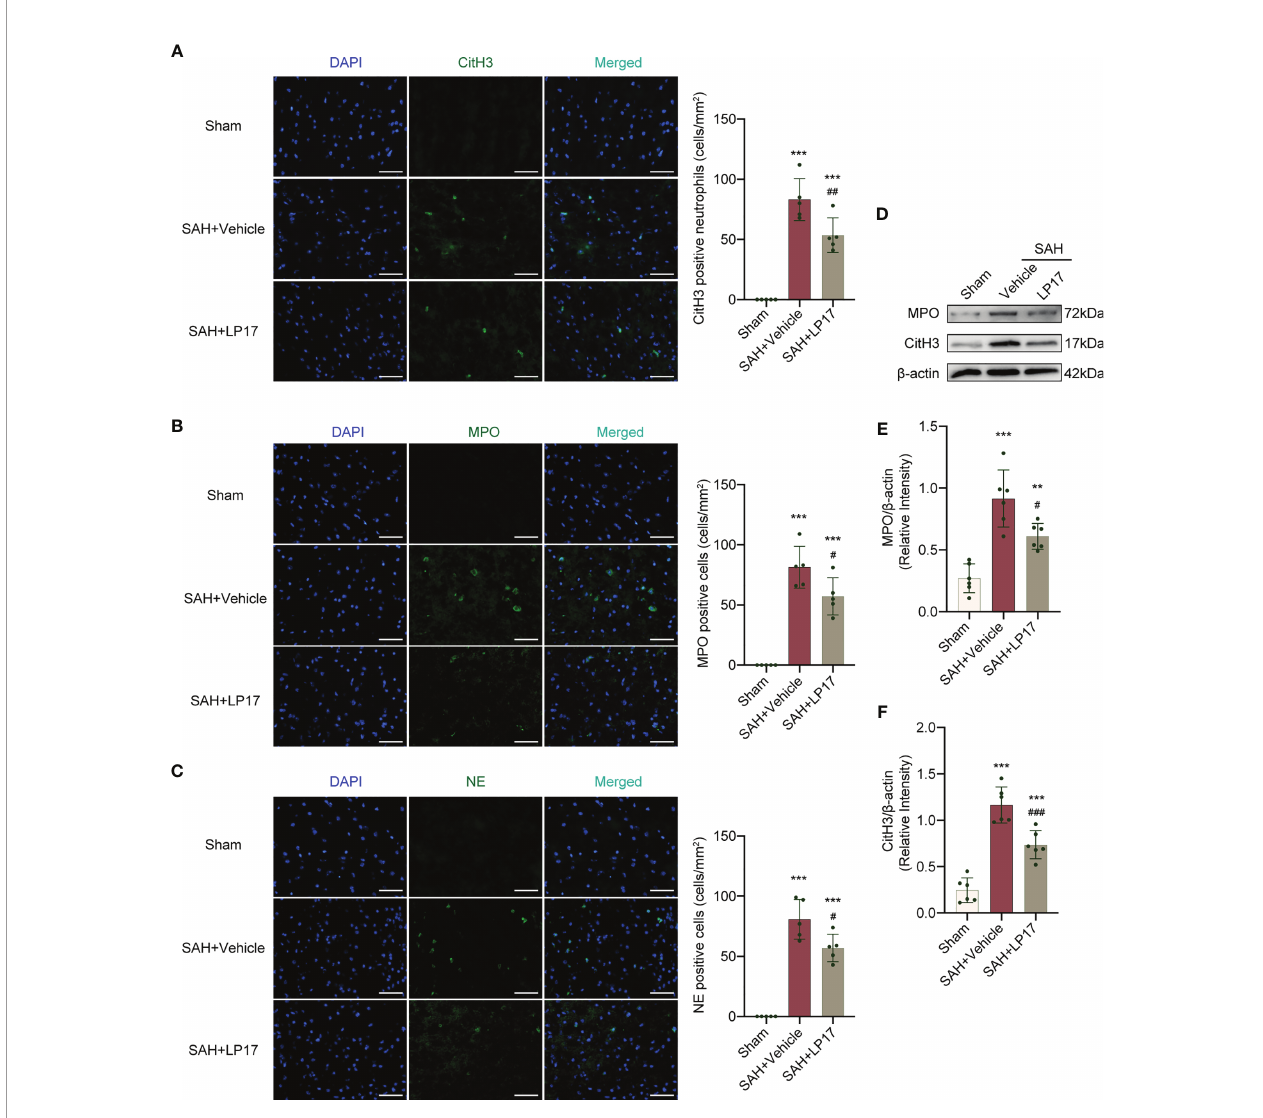
FIGURE 5 | LP17 treatment inhibited the formation of NETs. (A) Representative photograph and quantitative analysis showed the CitH3 positive cell (green) in different groups. n = 5/group. (B) Representative photograph and quantitative analysis showed the MPO positive cell (green) in different groups. n = 5/group. (C) Representative photograph and quantitative analysis showed the NE positive cell (green) in different groups. n = 5/group. (D – F) Representative western blotting images and quantitative analysis of MPO and CitH3 in cortex in different groups. Control images of b -actin are re-used for illustrative purposes. n = 6/group. Data are expressed as mean ± SD. **P < 0.01, ***P < 0.001 vs Sham group; # P < 0.05, ## P < 0.01, ### P < 0.001 vs SAH+vehicle group. Scale bar = 50 m